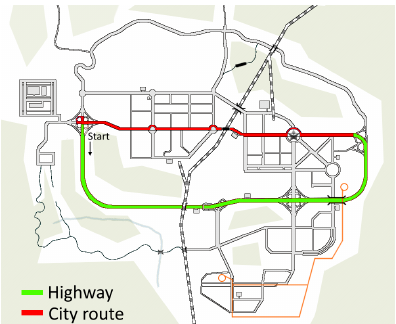
Figure 3. Map of the course, which consists of a highway section and a city